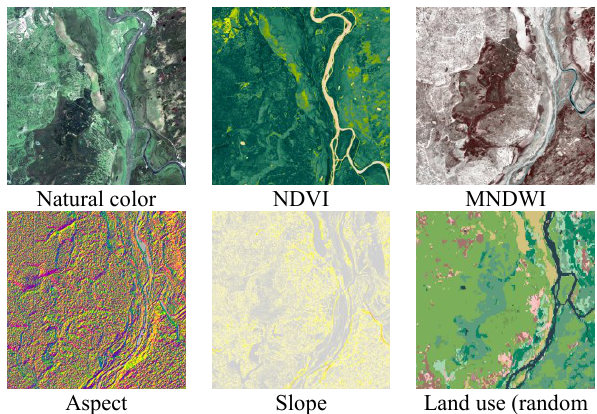
Figure 3 . Ground-truth and forecasting water surface